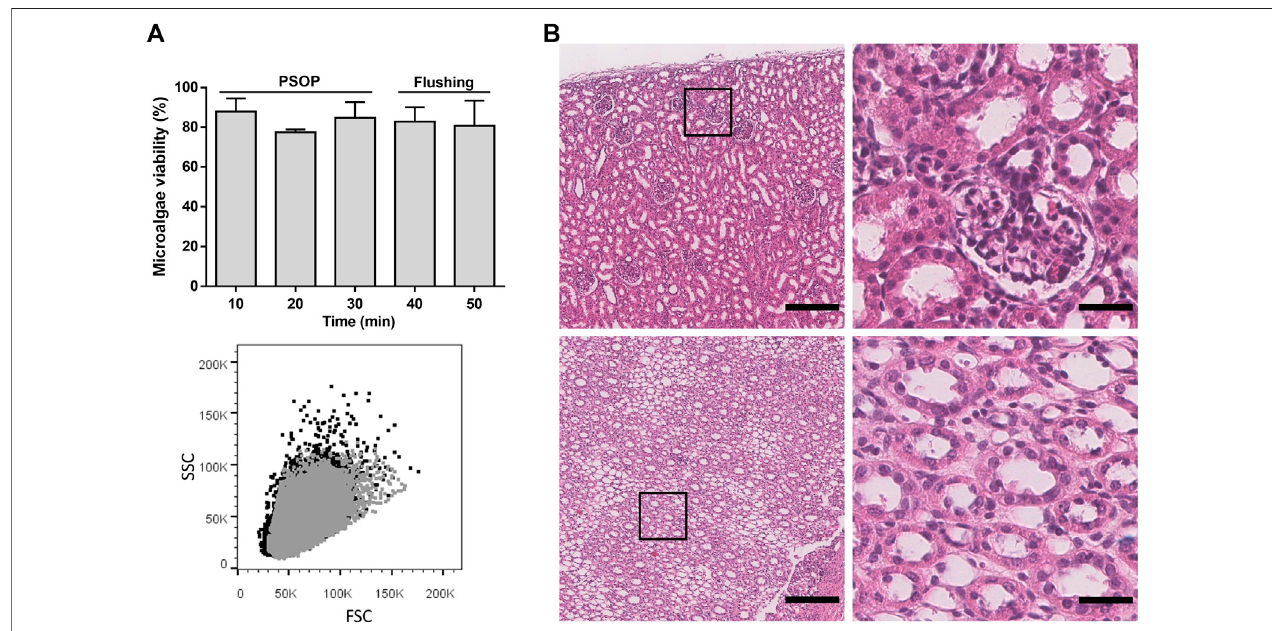
FIGURE7| Microalgaeviabilityandrenaltissue integrityafterdynamicphotosyntheticperfusion.Viability[ (A) ,upper]andmorphology[ (A) ,lower]ofthemicroalgae were not affected by the perfusion and the subsequent fl ushing step. H&E-stained paraf fi n sections, shows a normal histological structure of porcine kidneys in cortex [ (B) ; top] and medulla [ (B) ; bottom] after perfusion. Black and grey dots in A (bottom) indicate microalgae samples of the solution obtained before and after 10 min of perfusion,respectively,showinganalmostcompleteoverlappingofthesignalwheregraydotsmaskedthemicroalgaepopulationrepresentedbyblackdots.Scale bar represents 200 µm [ (B) , left] and 30 µm [ (B) , right]. Data are expressed as mean ± SD; N (cid:2) 2 in